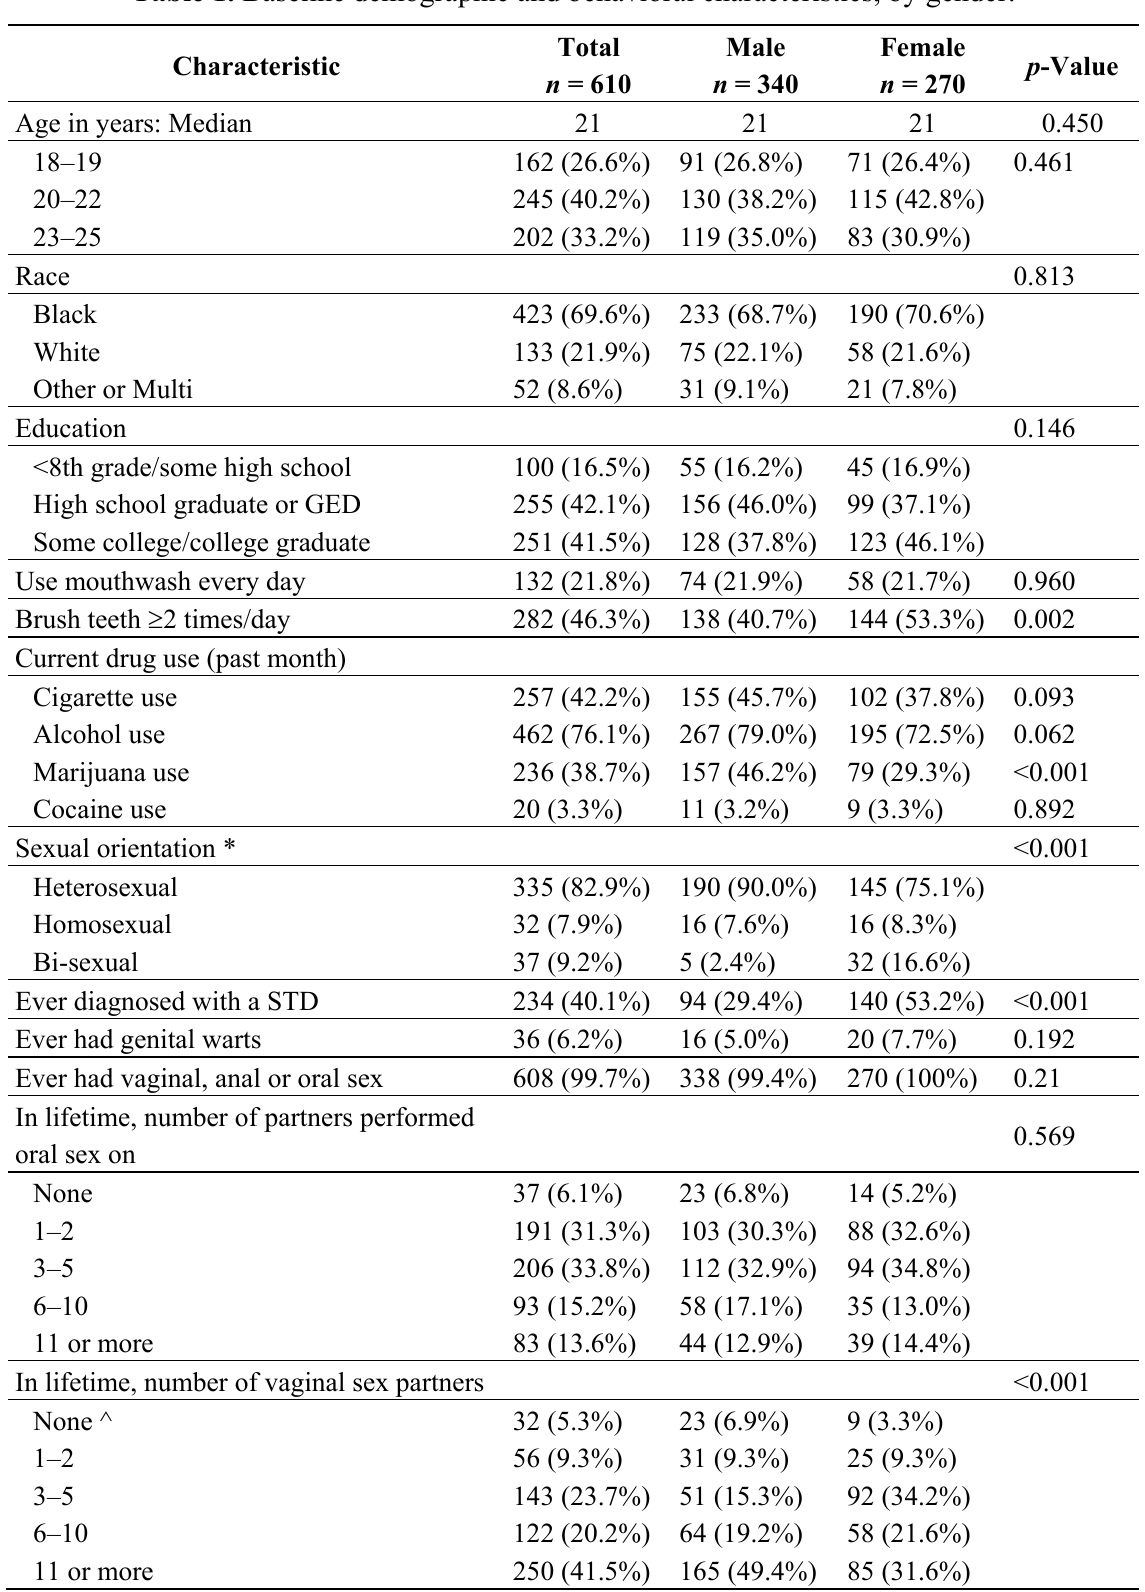
Table 1. Baseline demographic and behavioral characteristics, by